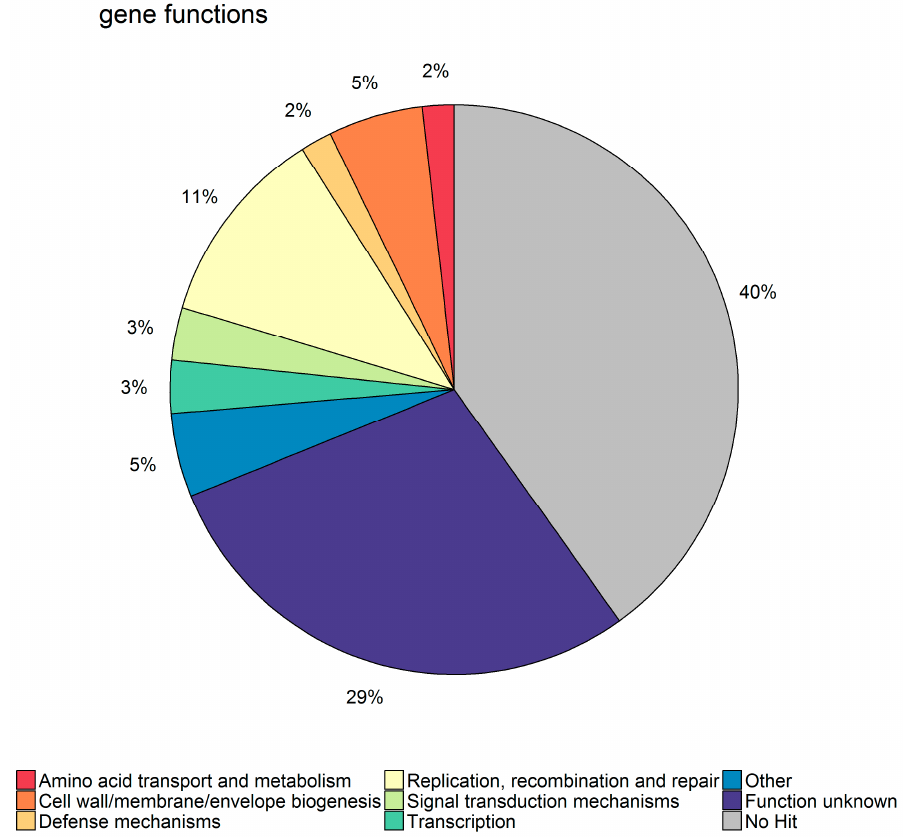
Figure 5. Functional annotation categories of the eggNOGs matching to the set of significant genes across all nine phages.